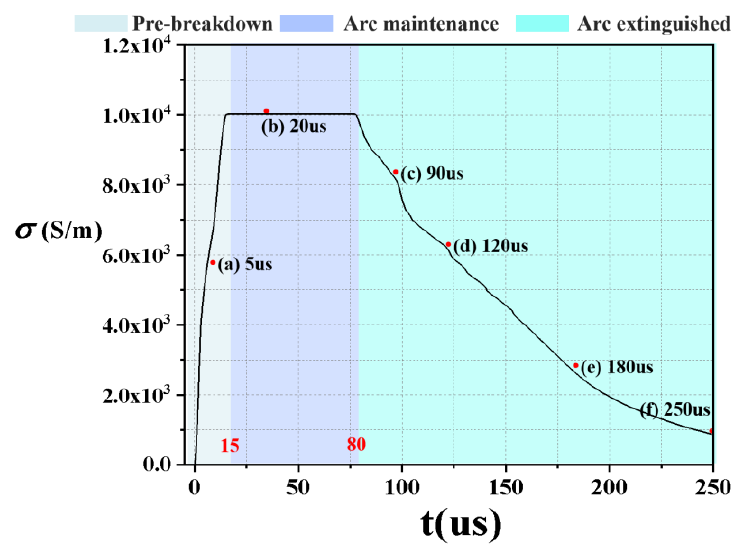
Figure 3. Simulation curve of conductivity change.